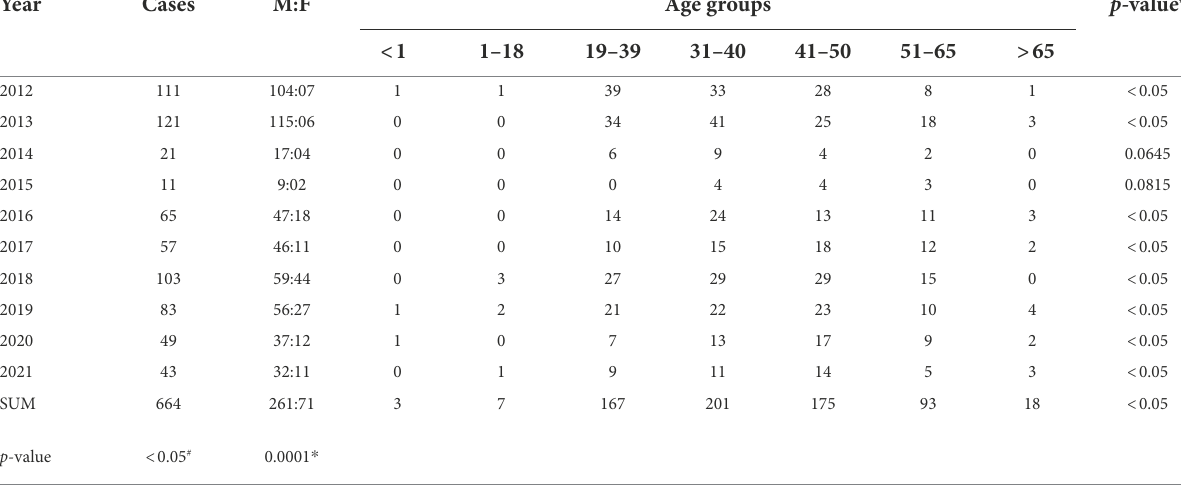
TABLE 1 Occurrence of Candida albicans in different age groups and